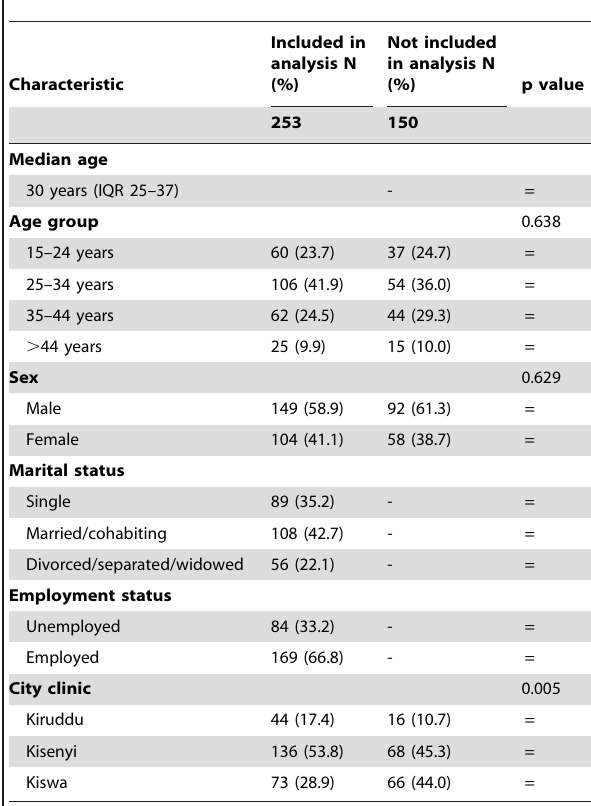
Table 1. Socio-demographic, clinical and